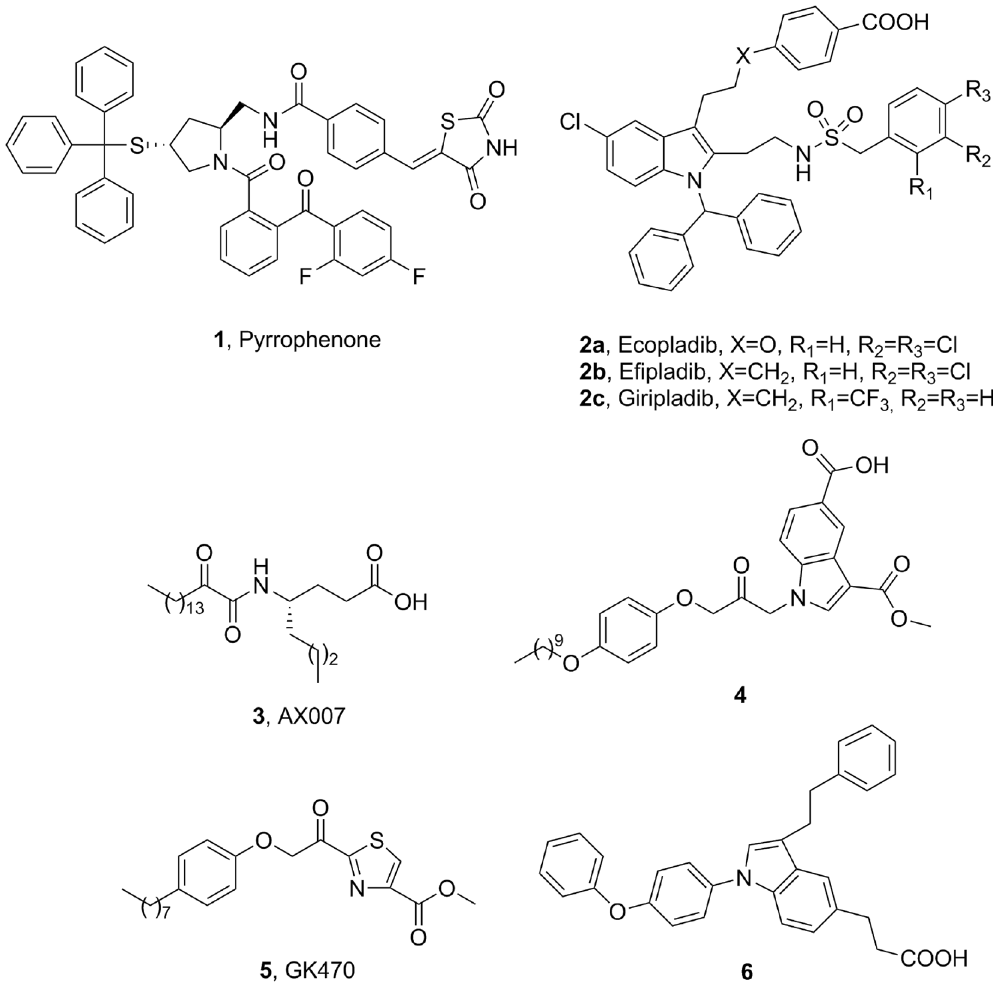
Figure 1. Common inhibitors of phospholipases A 2